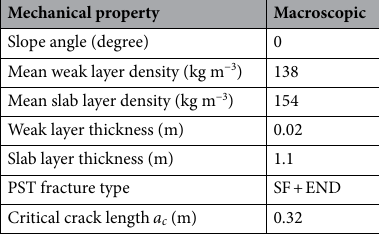
Table 1. Properties of PST